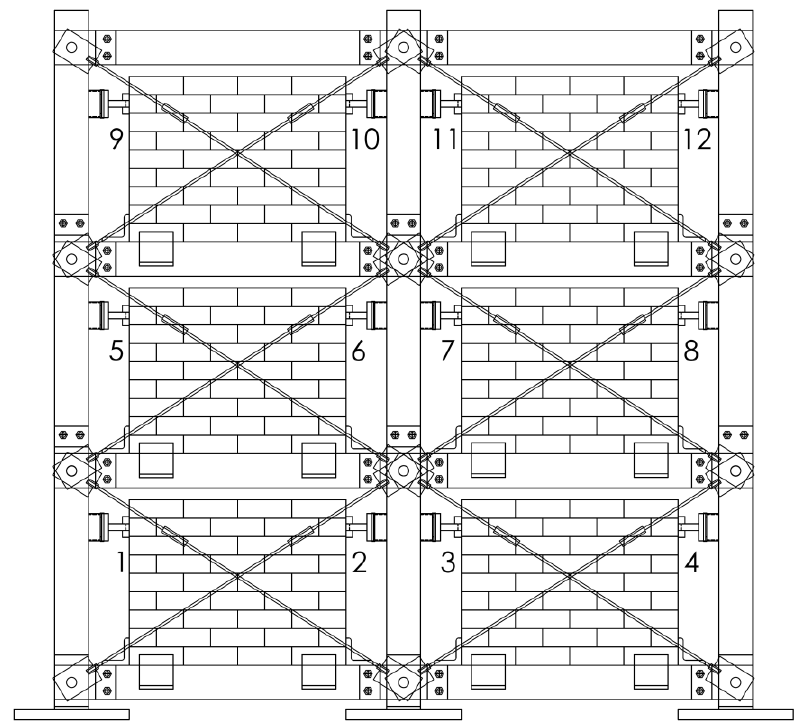
Figure 7. Fuse element locations on test